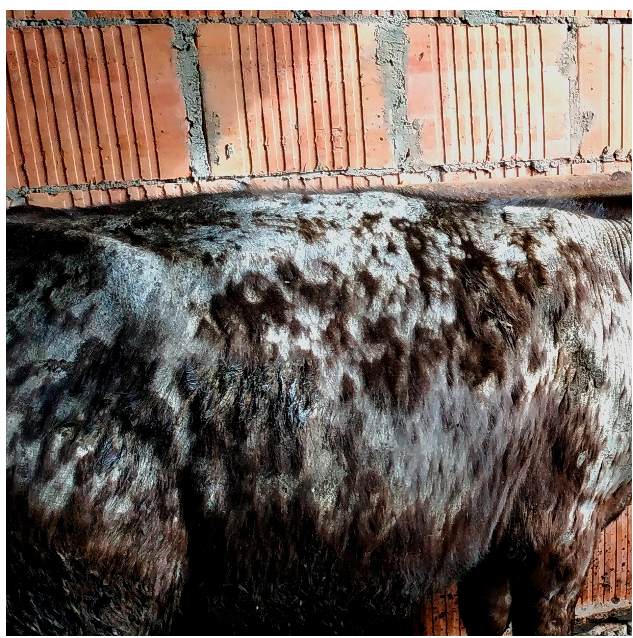
Figure 1. Clinical lesions in the skin and hair of a cow affected by ringworm (camera: Nikon